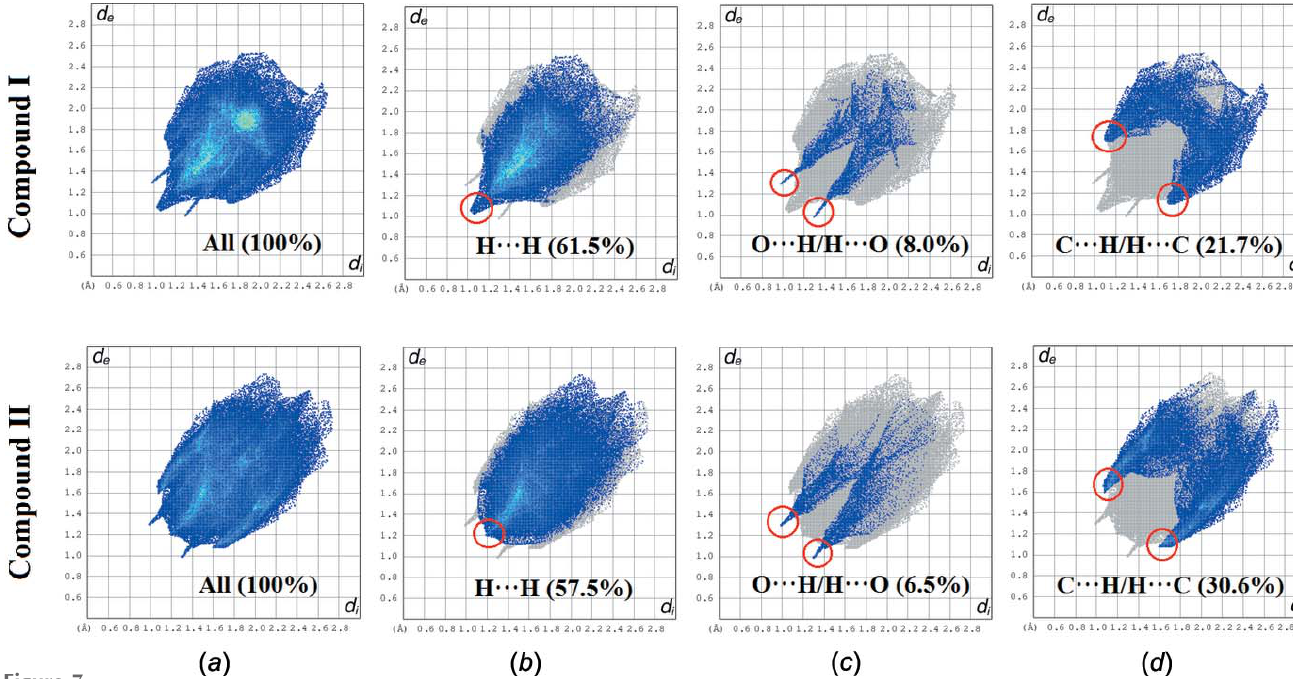
Figure 7 Fingerprint plots of interactions, listing the percentage of contacts ( a ) full two-dimensional fingerprint plots; ( b ) H (cid:2)(cid:2)(cid:2) H ( c ) O (cid:2)(cid:2)(cid:2) H/H (cid:2)(cid:2)(cid:2) O and ( d ) C (cid:2)(cid:2)(cid:2) H/ H (cid:2)(cid:2)(cid:2) C contributions to the total Hirshfeld surface. The outline of the full fingerprint plots is shown in grey.